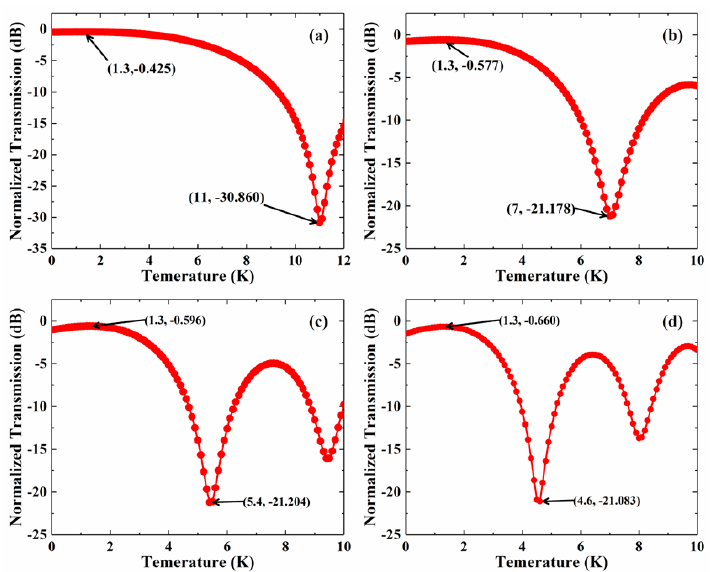
Figure 4. The relationship between IL and temperature change over ( a ) 1-period, ( b ) 2-period, ( c ) 3–period, and ( d ) 4-period-long intervals.